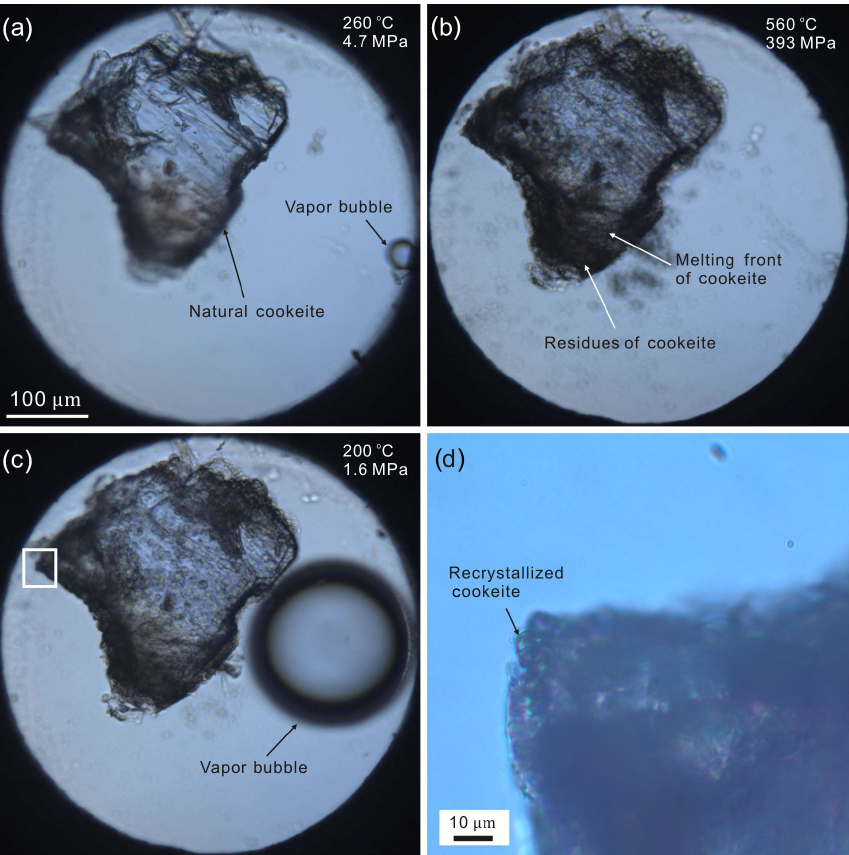
Figure 7. Images of the HDAC sample chamber during the cookeite recrystallization experiment: (a) natural cookeite surrounded by pure H 2 O at 260 ◦ C and 4.7MPa (bulk H 2 O density = 0 . 78205gcm − 3 ; vapor bubble disappears at 261 ◦ C); (b) cookeite dissolving in water at 560 ◦ C and 393MPa ( ∼ 40% cookeite (by volume) has melted, leaving residue behind the melting front); (c) the recrystallized cookeite at 200 ◦ C and 1.6MPa (vapor bubble appears during cooling); and (d) recrystallized cookeite (enlargement of the area enclosed in the rectangle in c is highly transparent and provides distinct Raman signals; see Fig.